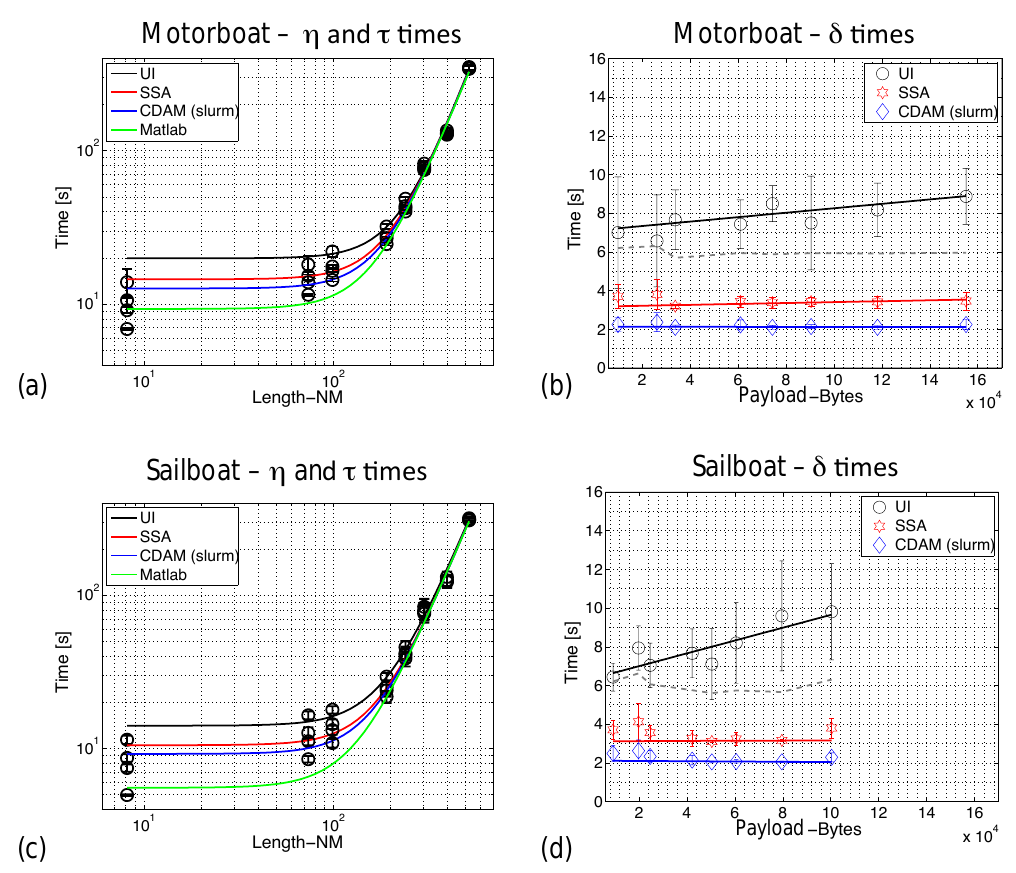
Figure 5. Performance of VISIR operational system, distinguishing between motorboat (a, b) and sailboat modality (c, d) . Left panels contain performance vs. route length L . The “UI”, “SSA”, and “CDAM (slurm)” times are respectively the quantities η(U) , η(S) , and η(C) , while “MATLAB” stands for τ(m) . Power-law least-square fits are displayed as solid lines, and fit parameters are given in Table 3. Right panels contain the δ(Q) = η(Q) − τ(m) times. Here linear fits are displayed as solid lines and the times δ(S) + t poll / 2 as dashed grey lines. The length of the vertical bar is given by 2 σ e , where the estimated standard deviation based on a sample of ν measurements is computed as q P − y) 2 /(ν − 1 ) σ e = i (y i